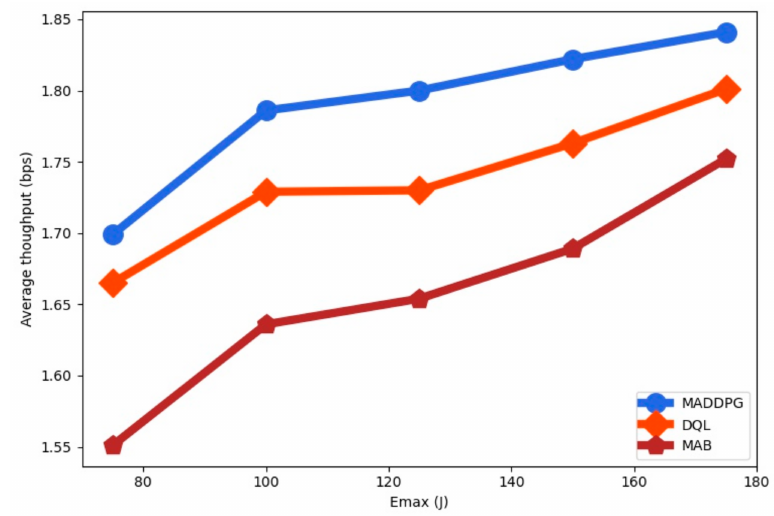
Figure 7. Average throughput as a function of the energy arrival E max